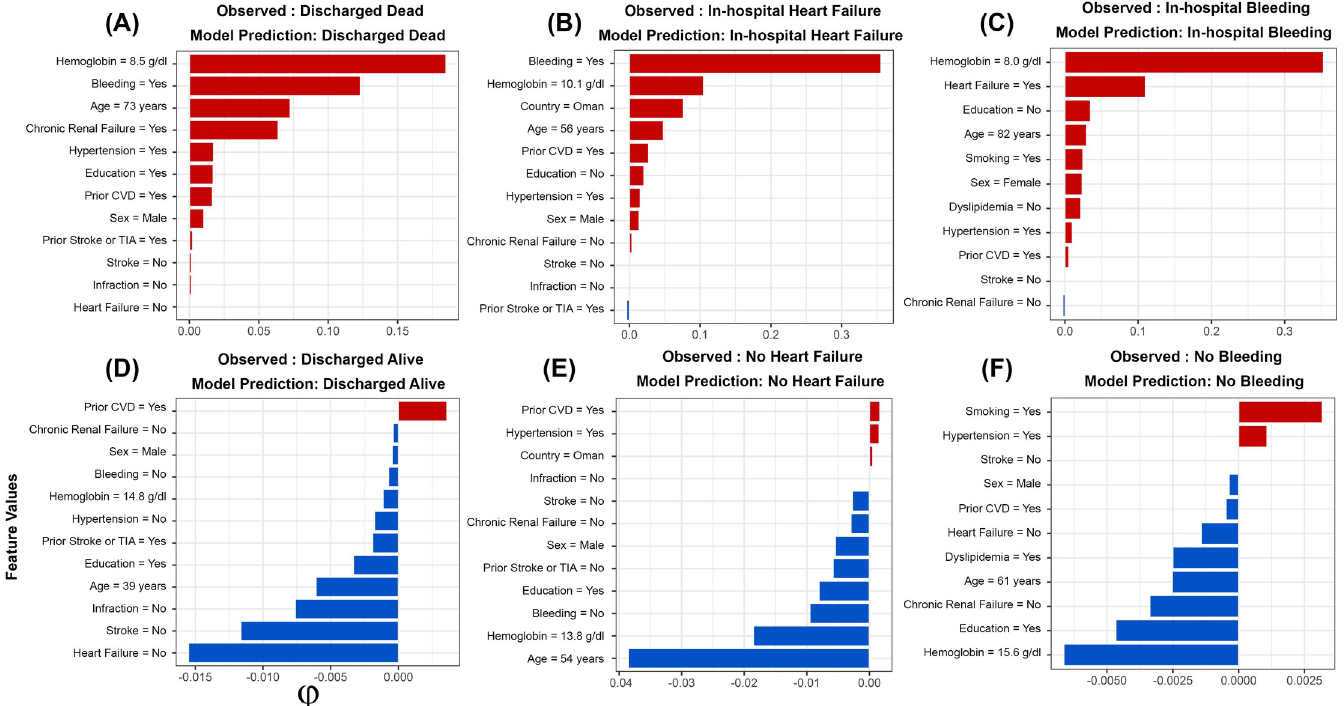
Fig 4. Value contributions for the respective risk of acute coronary syndromes (ACS) based on Shapley Values ( φ ) for Six Individual Patients. (A) a patient discharged dead; (B) a patient with an in-hospital heart failure; (C) a patient with an in-hospital bleeding; (D) a patient discharged alive; (E) a patient discharged alive with no in-hospital heart failure; and (F) a patient discharged alive with no in-hospital bleeding. Red bars indicate positive outcomes, and blue bars indicate negative outcomes. Positive Shapely value indicates that this feature increased the risk of ACS outcome, whereas negative values indicate that this feature decreased the risk of ACS outcome. The values next to each feature name indicate the observed value of that feature for that patient. � CVD: Cardiovascular disease; � TIA: Transient ischemic attack.